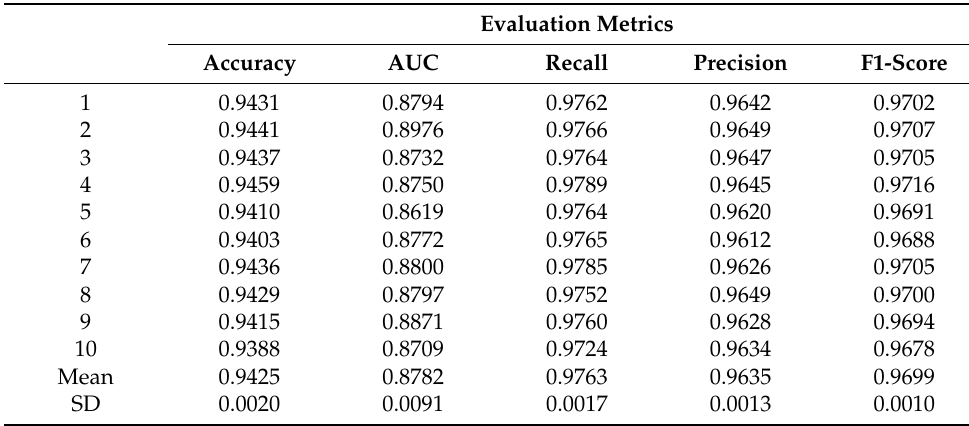
Table 5. The 10-fold cross-validation results for ExtraTree.